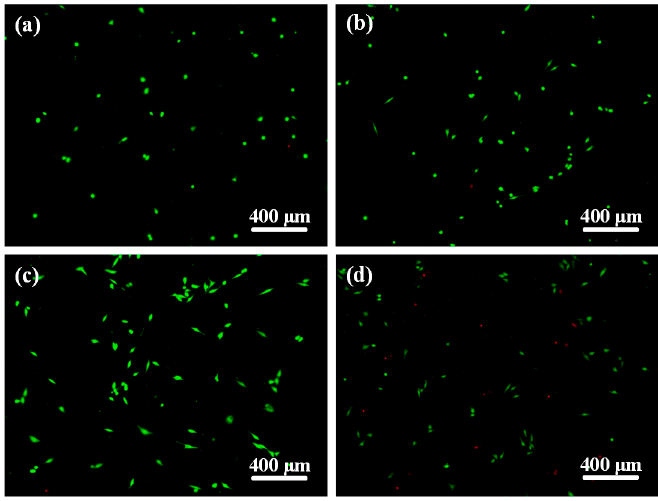
Figure 8. Fluorescent images of cells cultured on the scaffolds with: ( a ) 0 wt % (control); ( b ) 3 wt %; ( c ) 5 wt % and ( d ) 10 wt % ZnOw for one day.